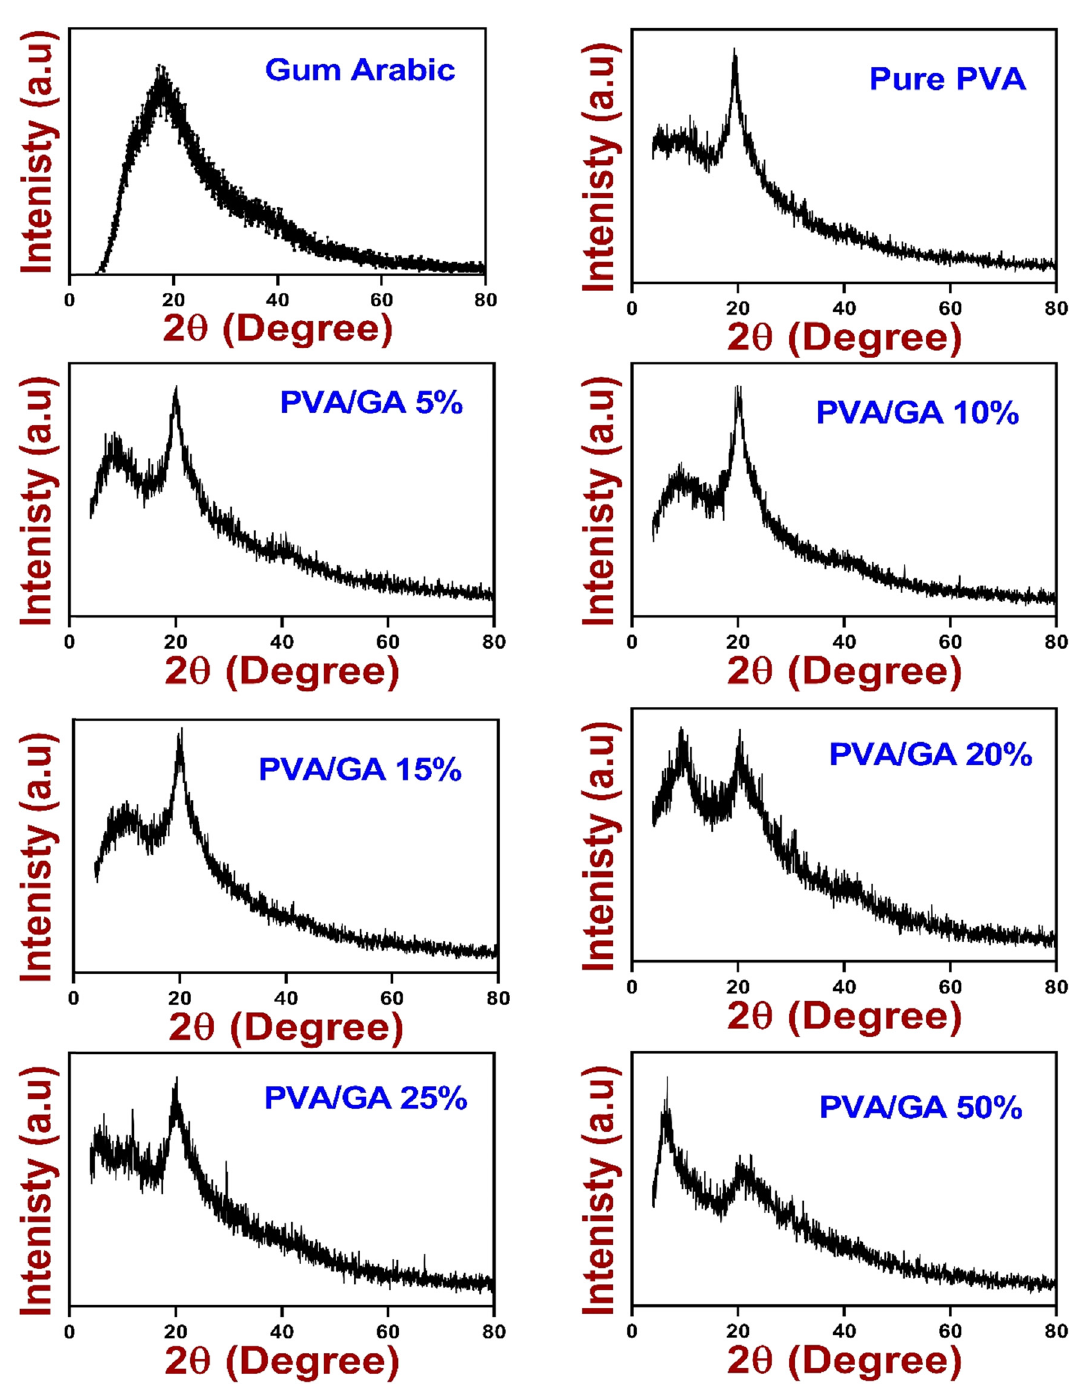
Figure 2: XRD of GA, PVA hydrogel, and the prepared PVA/GA x . Concentrations ( x ) of GA are from 5% to